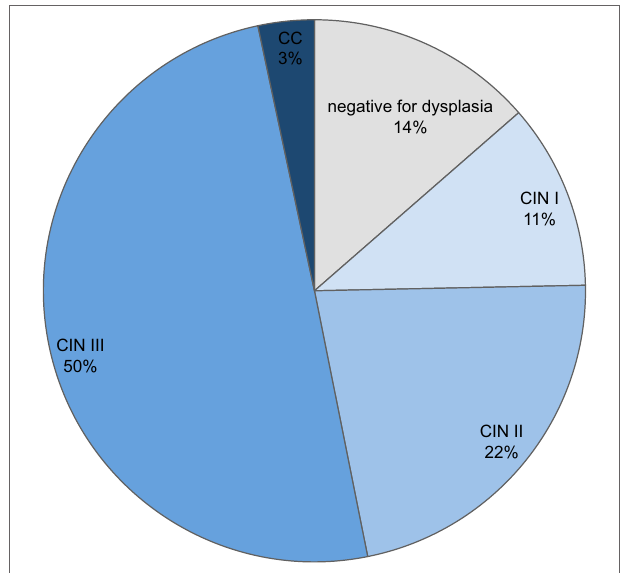
FigUre 1 | Findings in conizations in Central Switzerland, 2000–2014. In total, 272 conizations showed no evidence of dysplasia, 220 showed CIN1,